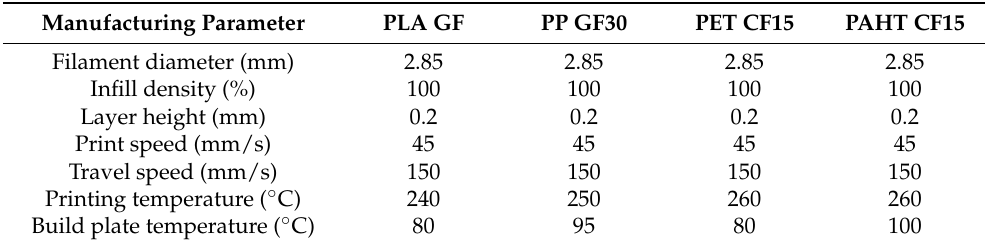
Table 3. Established parameters for manufacturing landing gear models by the FFF